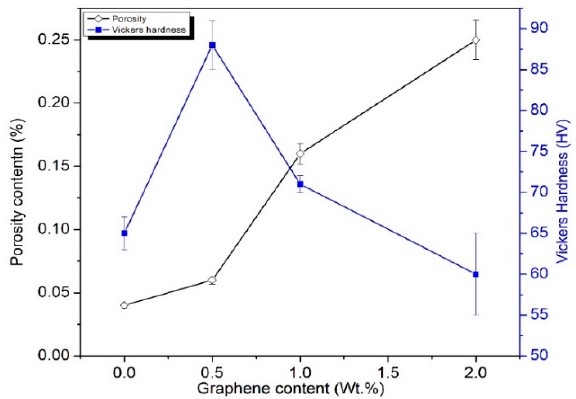
Figure 6. Porosity content and Vickers hardness variations as a function of graphene content.